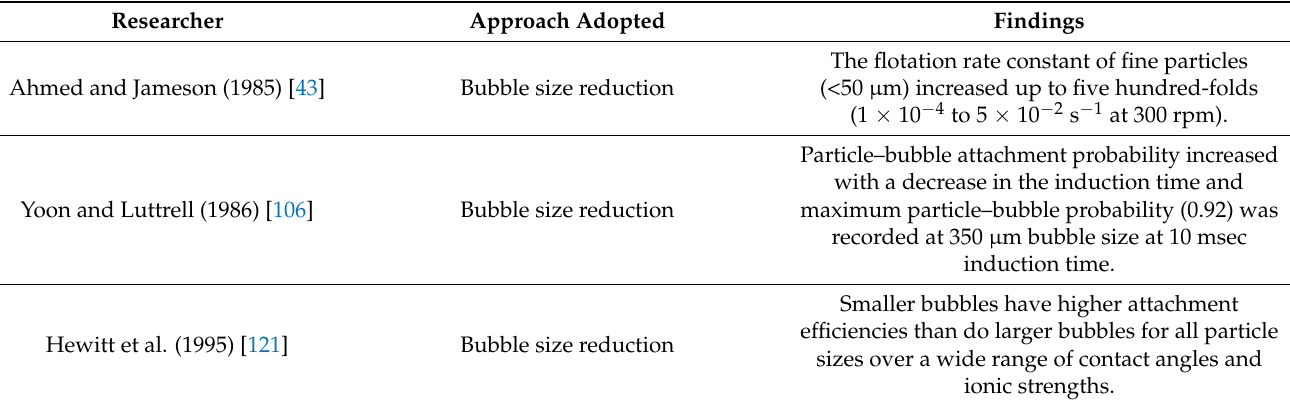
Table 1. Summary of several approaches adopted by different researchers to enhance fine particle